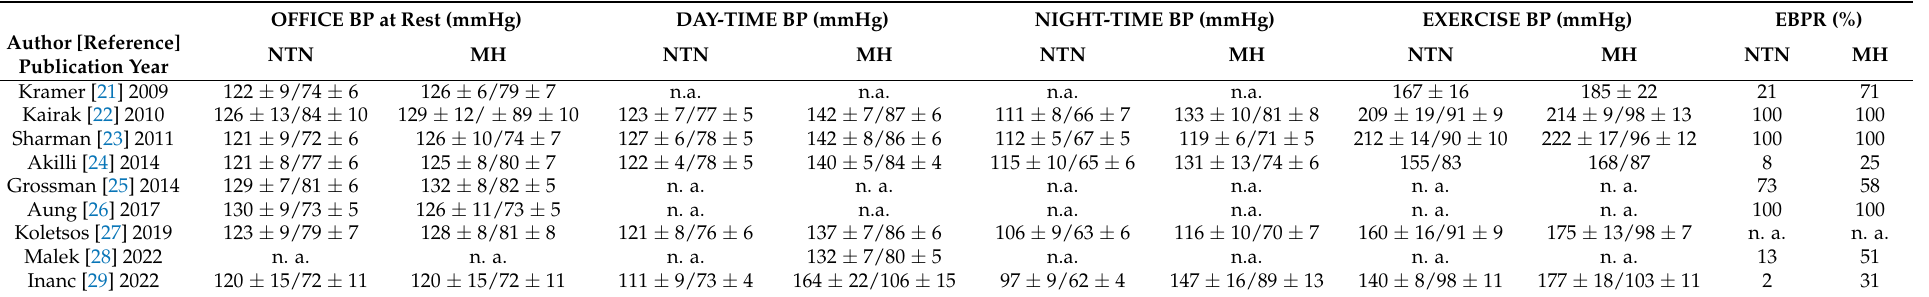
Table 2. Rest, exercise, and ambulatory blood pressure values of individuals with true normotension and masked hypertension in nine studies targeting exaggerated blood pressure response to exercise. Data are presented as absolute numbers, percentage, mean ± SD, BMI = body mass index; BP = blood pressure; EBPR = exaggerated blood pressure response to exercise; MH = masked hypertension; NTN =